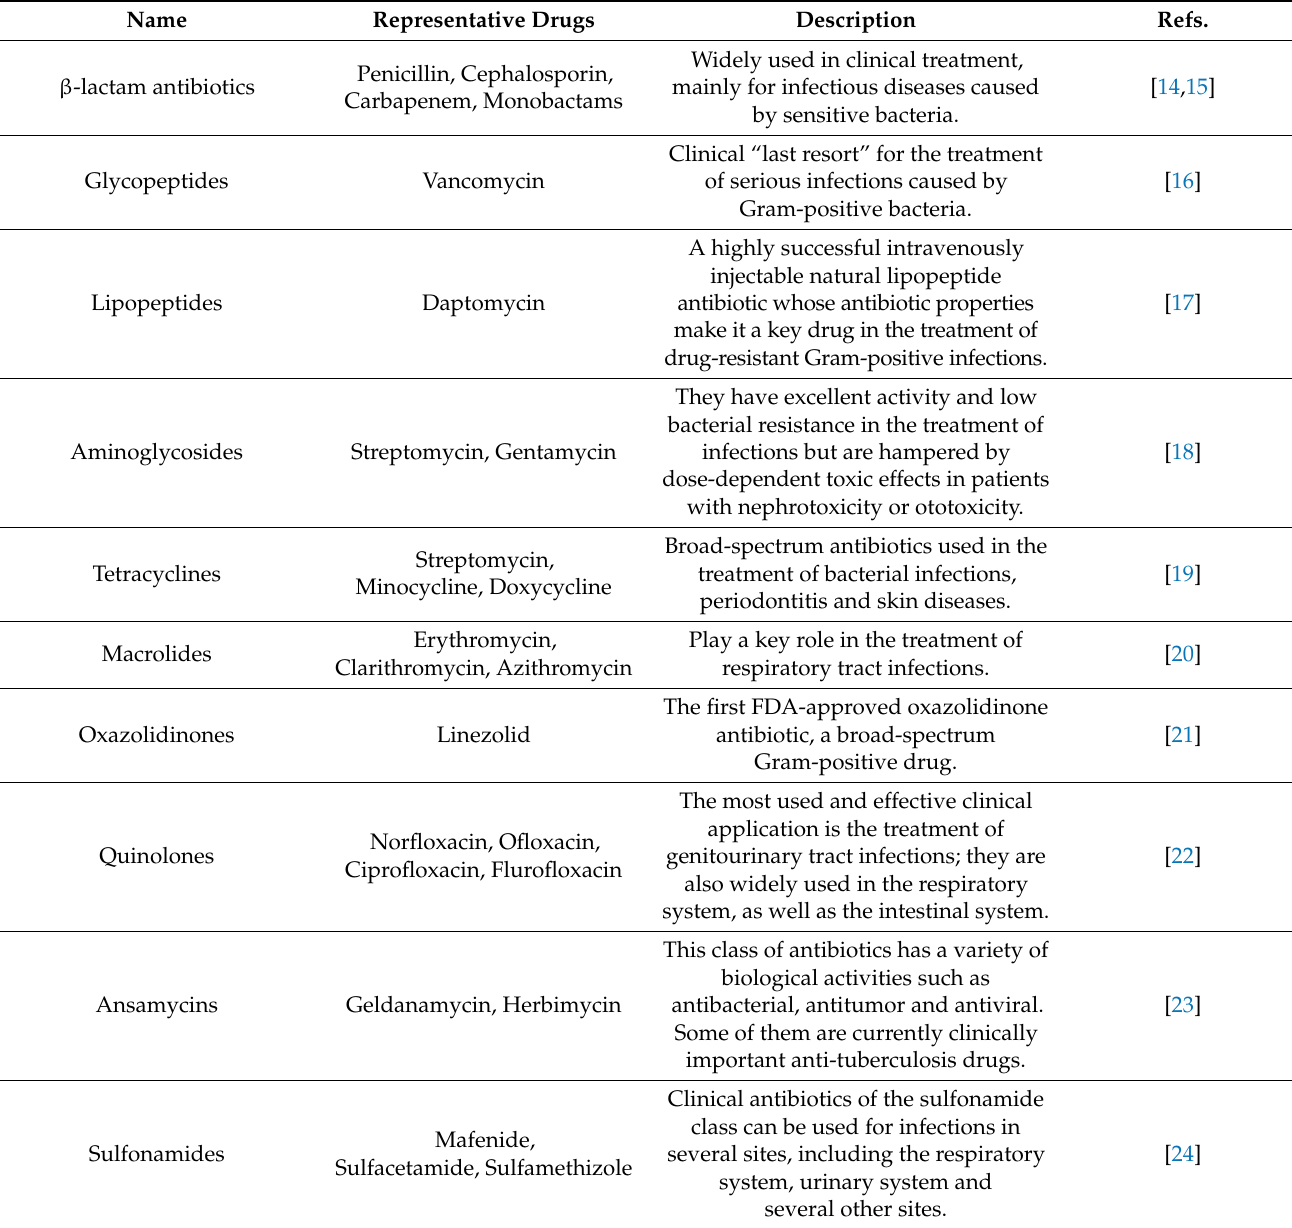
Table 1. Classification of traditional